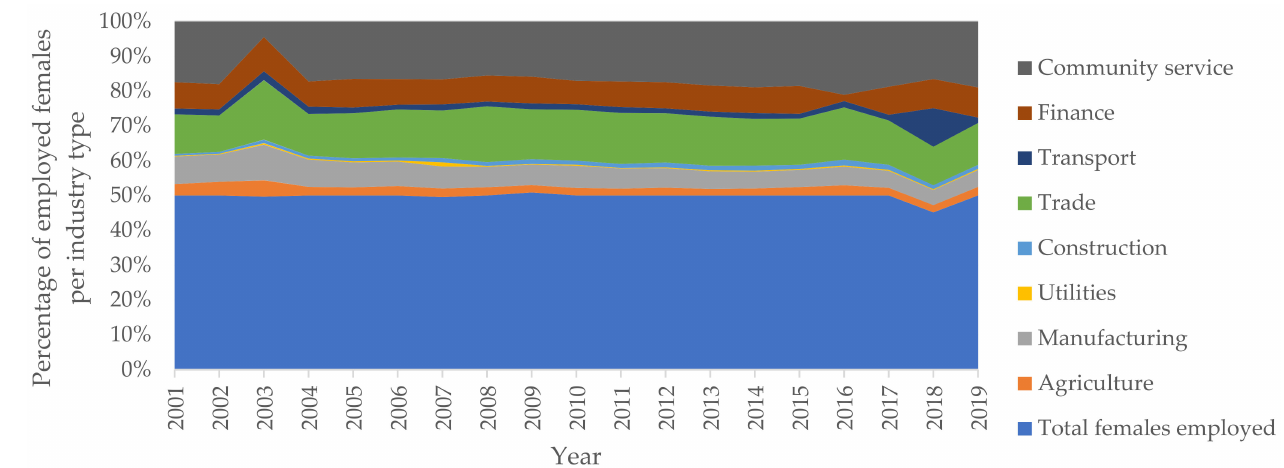
Figure 4. Female employment in South Africa (excludes mining, private